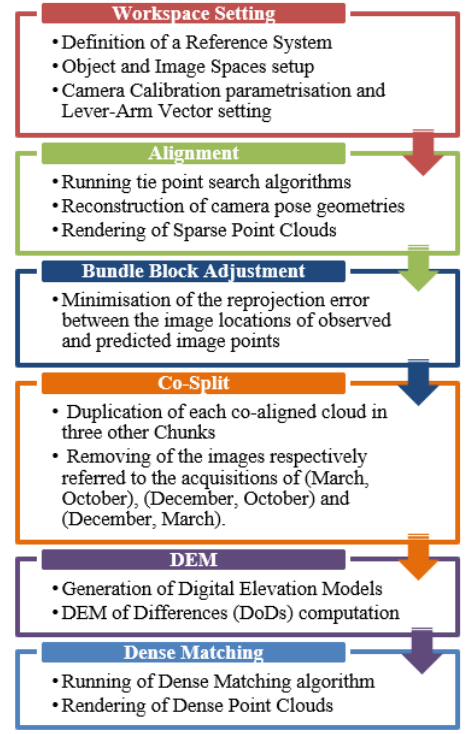
Figure 2. General sequence of steps designed for dataset